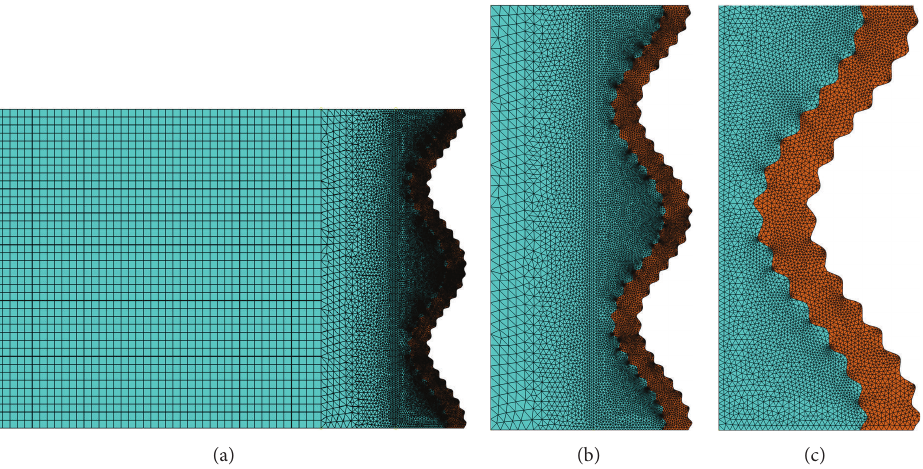
Figure 2: Typical element meshes at different length scales (half of model C).